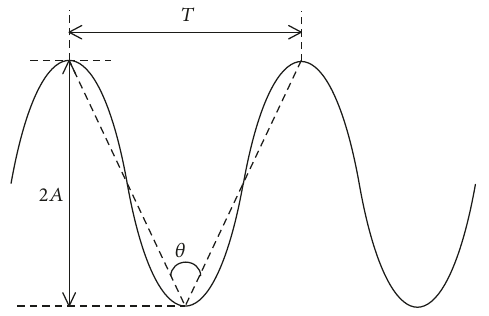
Figure 8: Sinusoidal surface structure.